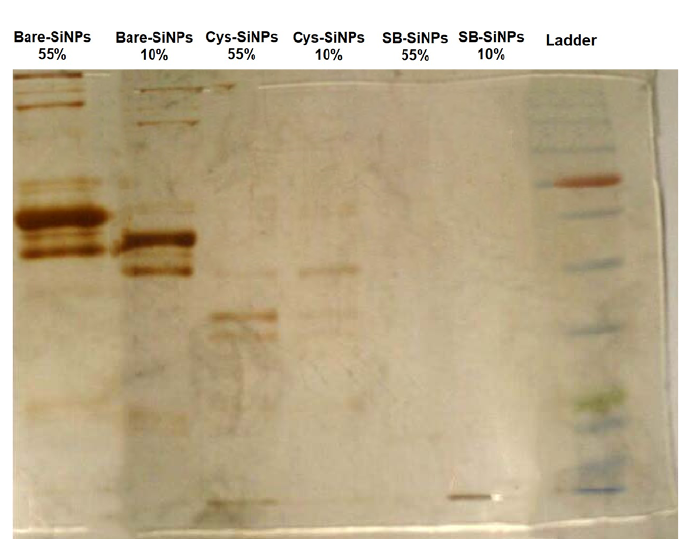
Fig. 3. The SDS-PAGE gel related to washed samples (two times with PBS), Bare- SiNPs (10-55%), Cys-SiNPs (10-55%) and SB-SiNPs (10-55%).